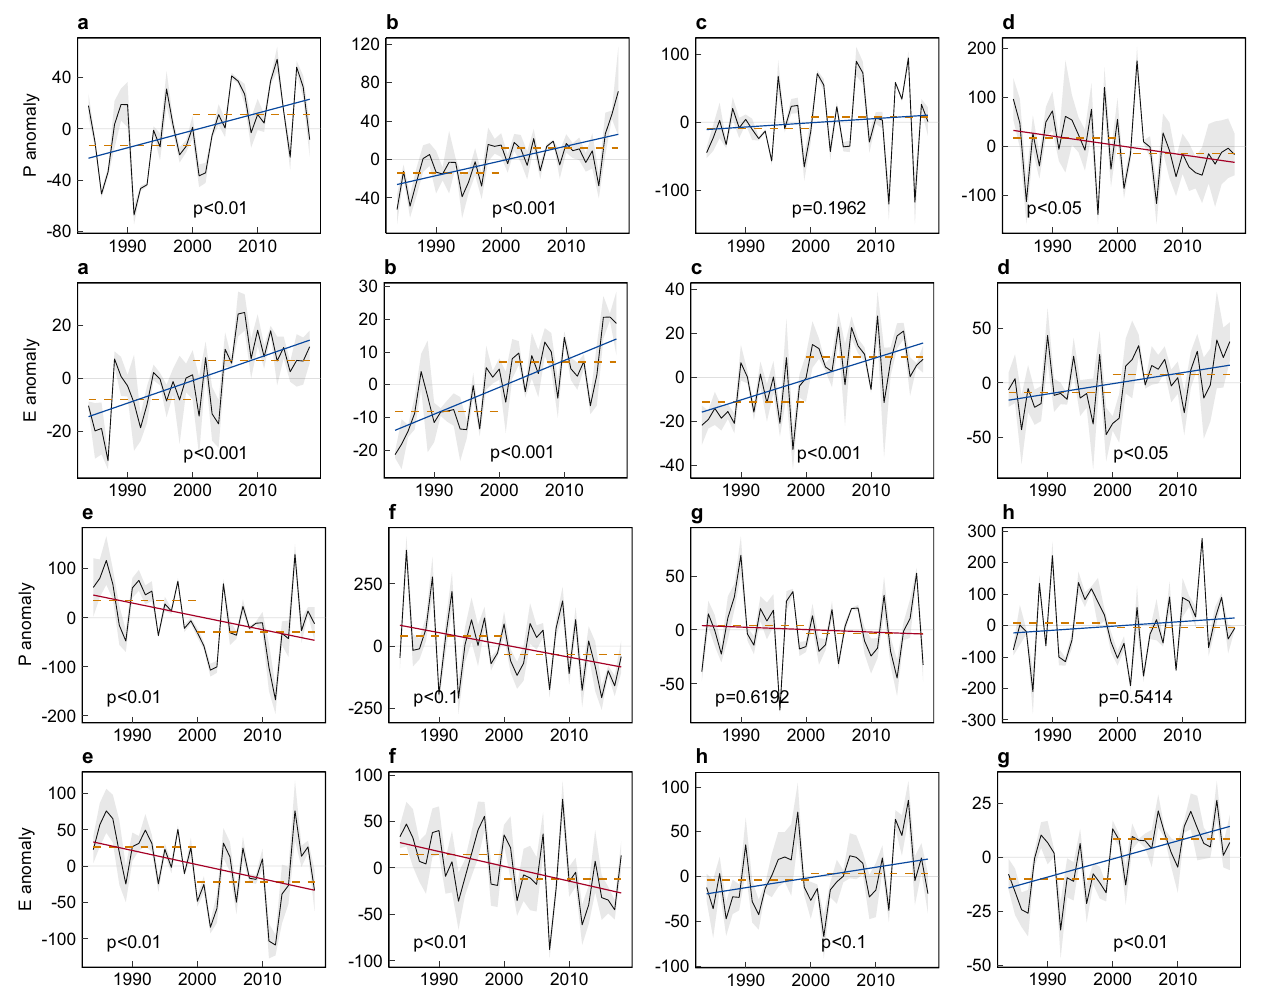
Fig.6 |Thetimeseriesofprecipitation(P)andevapotranspiration(E)anomaly fortheeightriverchangehotspots. Seelocationsofthehotspots(labeledas a – h ) in Fig. 5. The solid red lines show the fi tted linear trend ( p -value for the trend signi fi cance) of the time series. The dashed lines represent averages in the fi rst